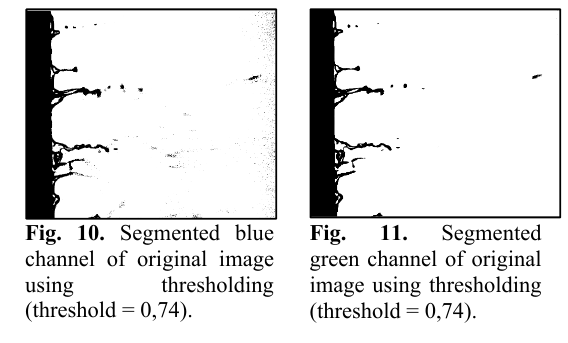
Fig. 11. Segmented green channel of original image using thresholding (threshold = 0,74).